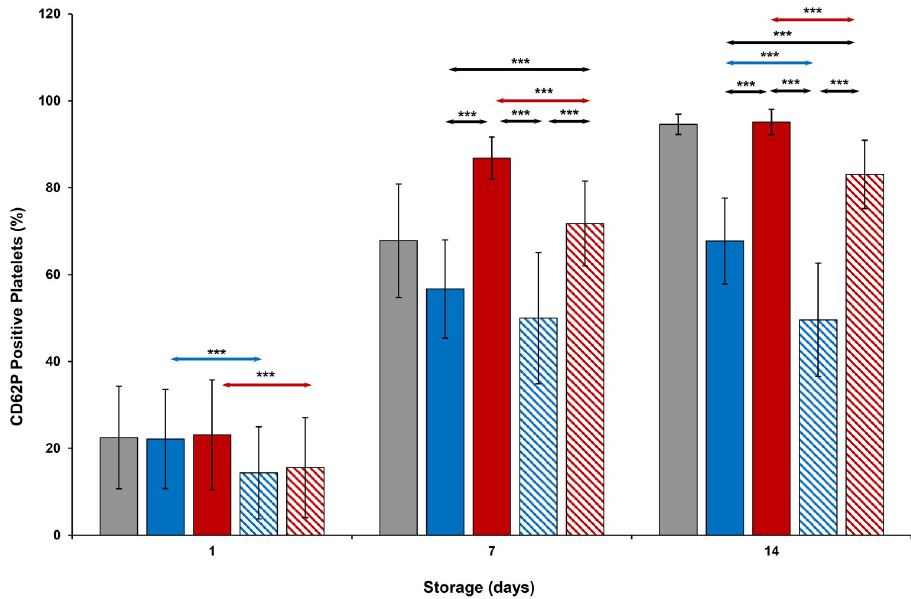
Fig 7. Effects of 14-day storage, temperature and presence of p38MAPK inhibitor on CD62P expression on platelets. Grey bar–platelets stored at room temperature; blue solid bar–cold-stored platelets; red solid bar– thermocycled-stored platelets; blue striped bar–cold-stored + VX-702 platelets; red striped bar–thermocycled-stored + VX-702 platelets. Data represents the mean of 15 experiments with one standard deviation. Arrows represent paired statistical differences; ��� —p < 0.001.